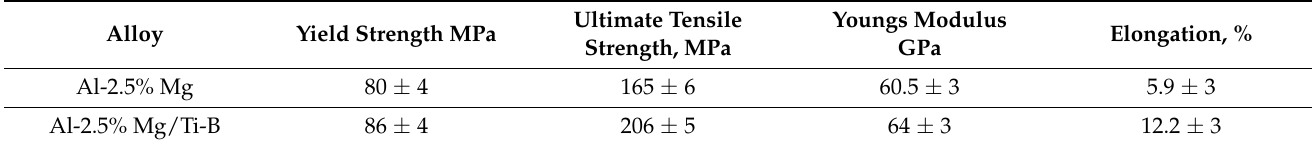
Figure 8. Stress-elongation dependence of the investigated alloys. Table 2. Mechanical properties of the investigated alloys from tensile test.